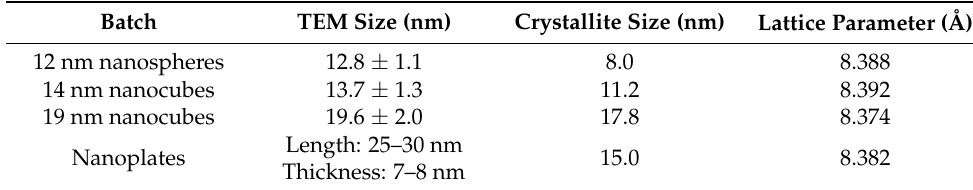
Figure 1. TEM images of ( A ) 12 nm sized nanospheres, ( B ) 14 nm sized nanocubes, ( C ) 19 m sized nanocubes, and ( D ) 30 nm length and 7 nm thickness nanoplatelets. Table 1. Average TEM size, crystallite size, and lattice parameter of various